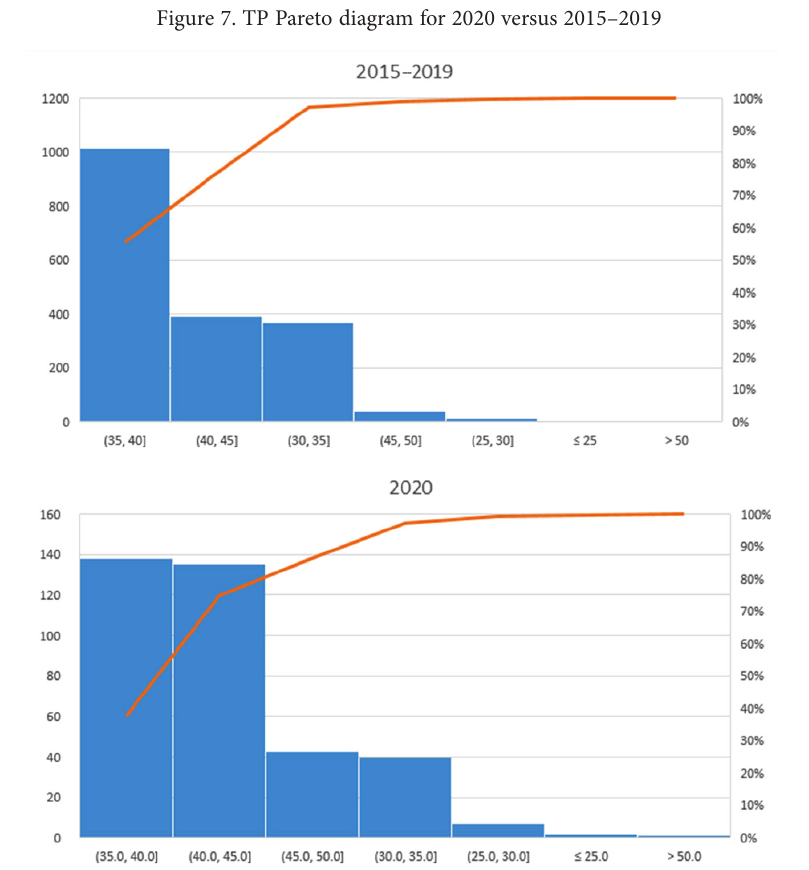
Figure 7. TP Pareto diagram for 2020 versus 2015–2019